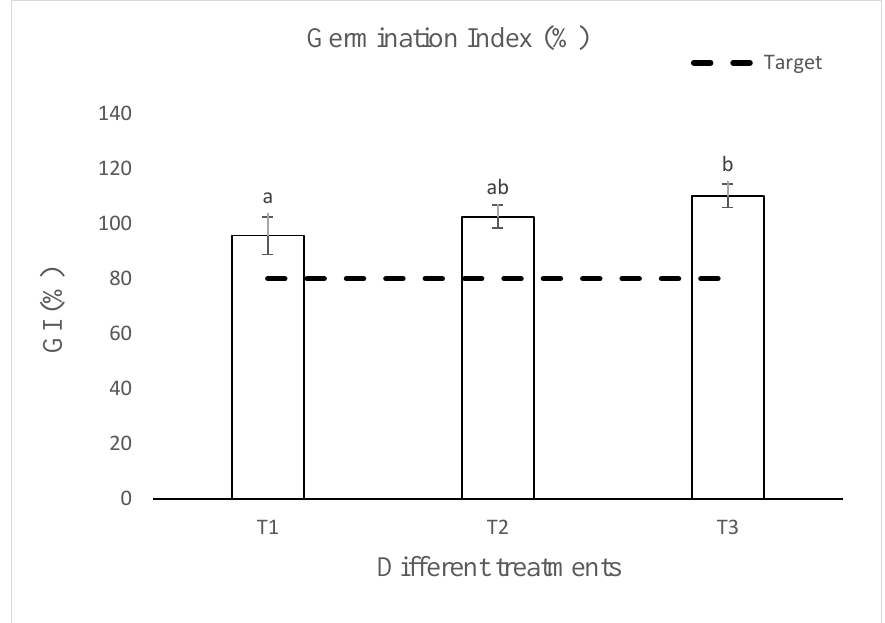
Figure 4. Germination index (GI) of Fenugreek seeds in different treatments of macrophytes amended with cow manure and nutrient supplements. The reference value of GI > 80 (Zucconi et al., 1981) was used. Values are the mean of three replicates, and bars indicate standard error (SD). Different letters indicate significance among different treatments at p < 0.05 (ANOVA; Tukey‘s HSD, p < 0.05).